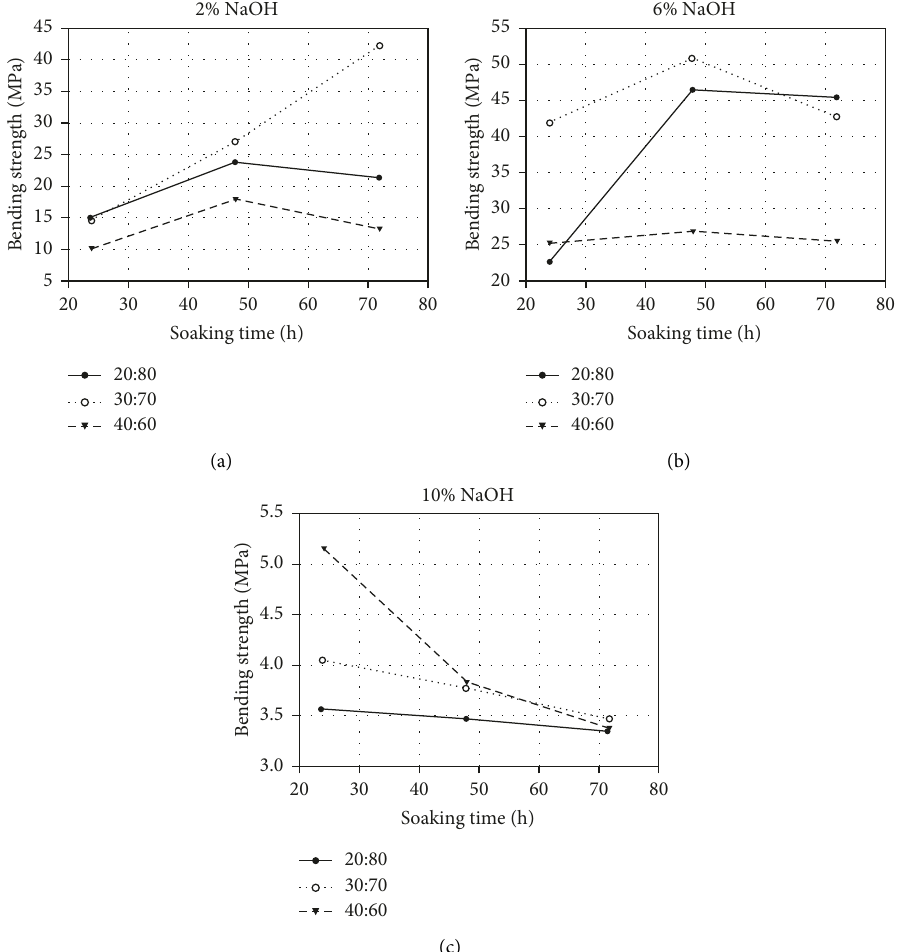
Figure 5: Effect of fiber to polyester ratio on bending strength of composites: (a) 2%, (b) 6%, and (c) 10%